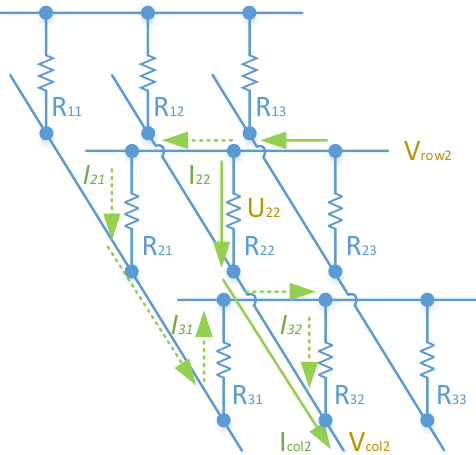
Figure 1. Crosstalk currents induced in the resistor array.